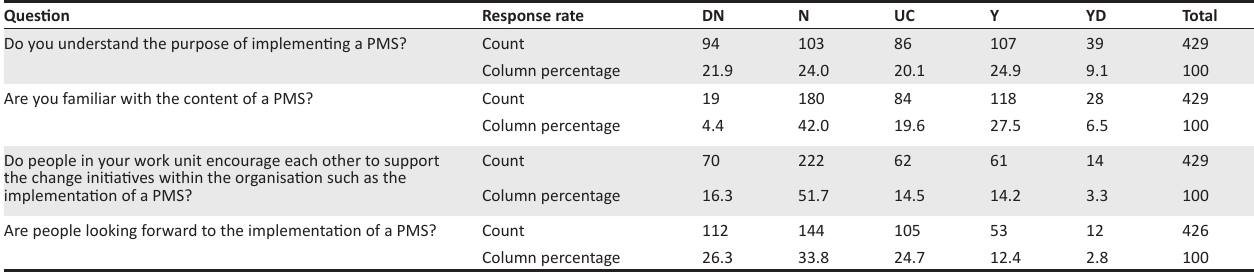
TABLE 4: Clear communication of purpose.